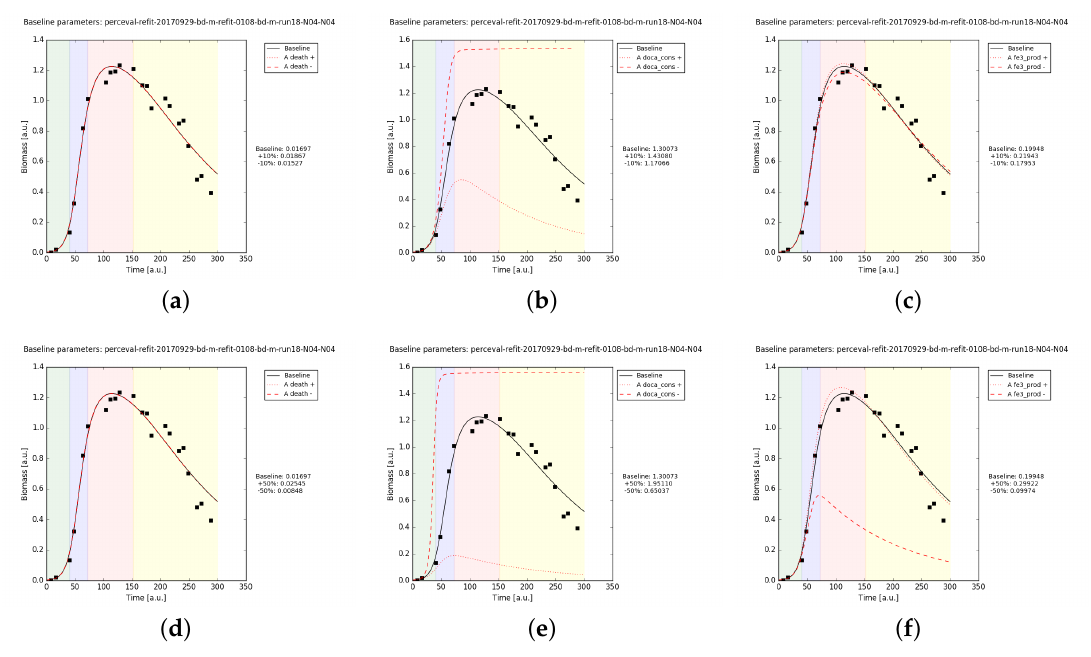
( A ) ( A ) and v prod , Fe DOC A